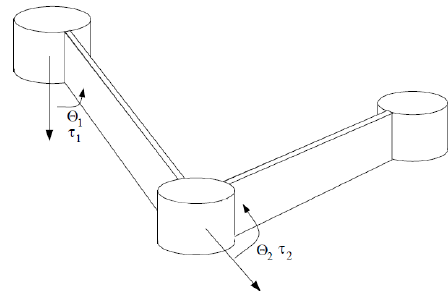
Figure 1. Two link robotic manipulator schema